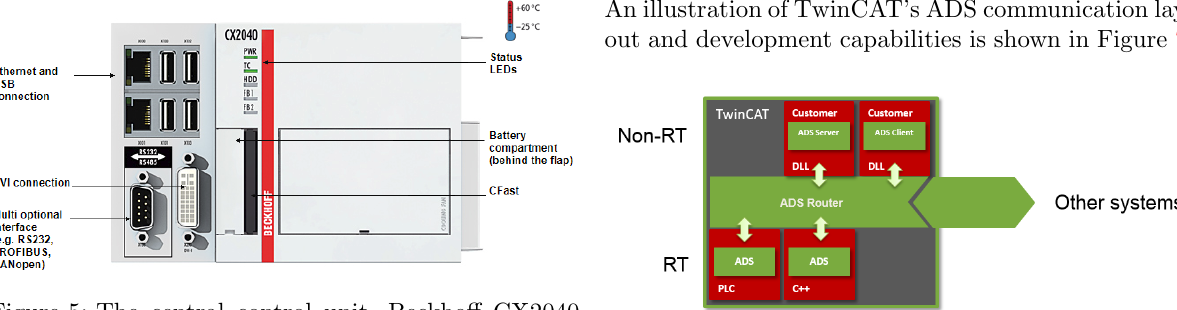
Figure 5: The central control unit, Beckhoff CX2040 (Beckhoff, 2018b).